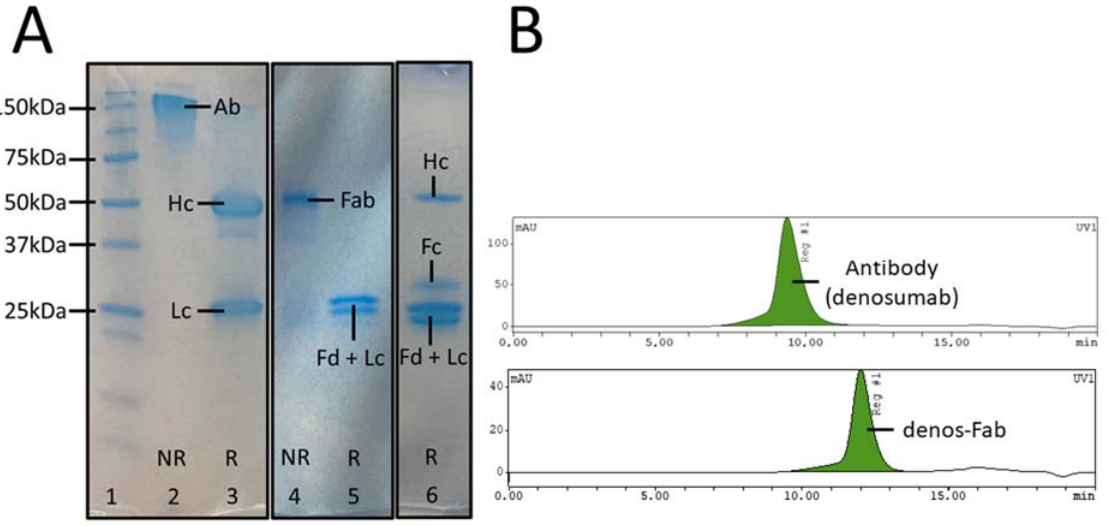
Figure 1. Fab fragment preparation and bioconjugation. ( A ) SDS ‐ PAGE of denosumab. Lane 1: molecular weight markers; lane 2: non ‐ reduced denosumab; lane 3: reduced denosumab; lane 4: non ‐ reduced Fab fragment; lane 5: reduced Fab fragment; lane 6: reduced digested denosumab mixture. ( B ) SEC ‐ HPLC of denosumab and purified Fab fragment (UV signal). (Ab = antibody, Hc = heavy chain, Lc = light chain, Fab = antibody Fab fragment, Fd = heavy chain of Fab fragment, Fc = crystallizable fragment region, NR = non reduced, R = reduced).